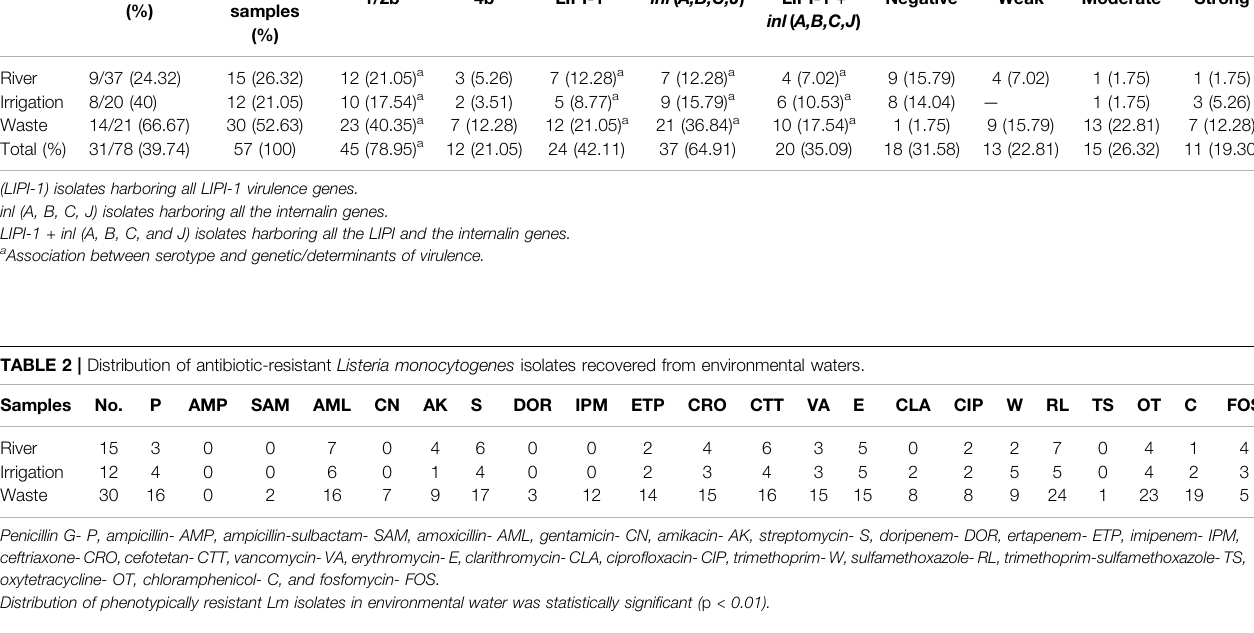
TABLE 1 | Occurrence, serotypes, phenotypic, and genotypic determinants of Listeria monocytogenes virulence recovered from environmental waters. Sample Prevalence type of Lm